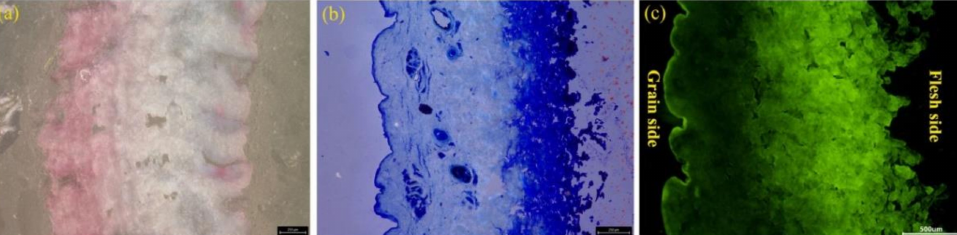
Figure 6. Images of slices with different tracing method for fatliquoring agent distributed in leather: ( a ) Sudan IV stained, ( b ) Nile Blue sulphate stained and ( c ) fluorescent tracing technology by